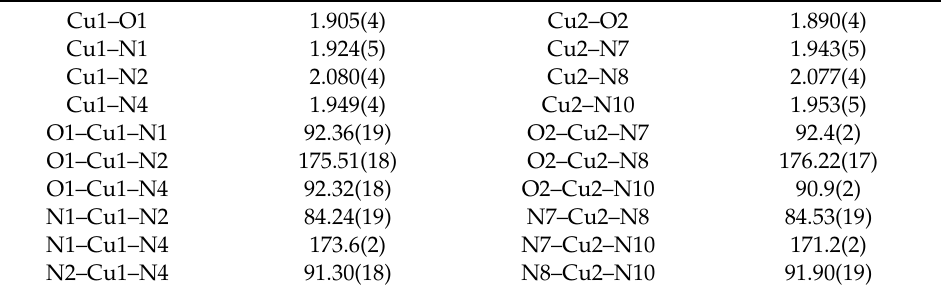
Figure 6. Representation of the supramolecular chain in 2 , viewed along the crystallographic c axis, with the inset showing synthon formed by H-bonding between Schiff base ligand, terminal azide group, and uncoordinated water molecule, as well as weak Cu–N contact. The hydrogen atoms are omitted for clarity. Colour scheme: Cu, cyan; O, red; N, blue; C, grey. Table 3. Selected geometrical parameters (distances / Å and angles / ◦ ) for 2